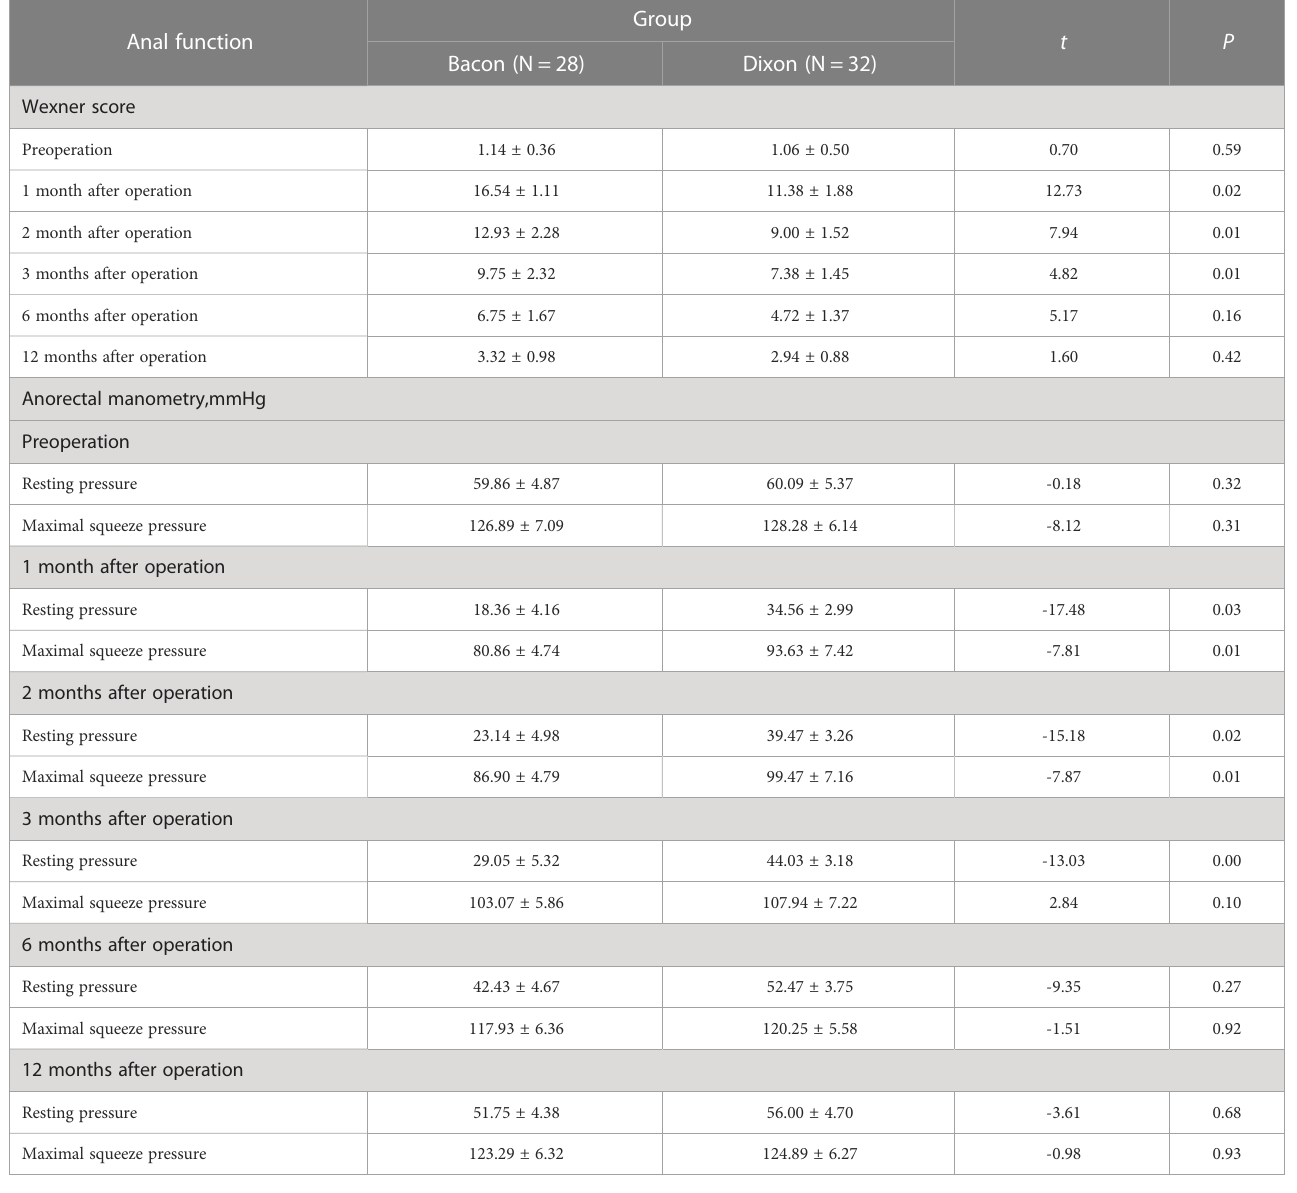
TABLE 4 Changes in anal function in patients without operation and after the second